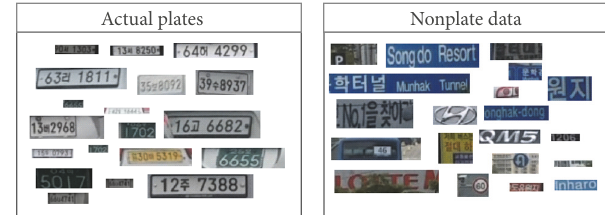
Table 2: Confusion matrices from experiment